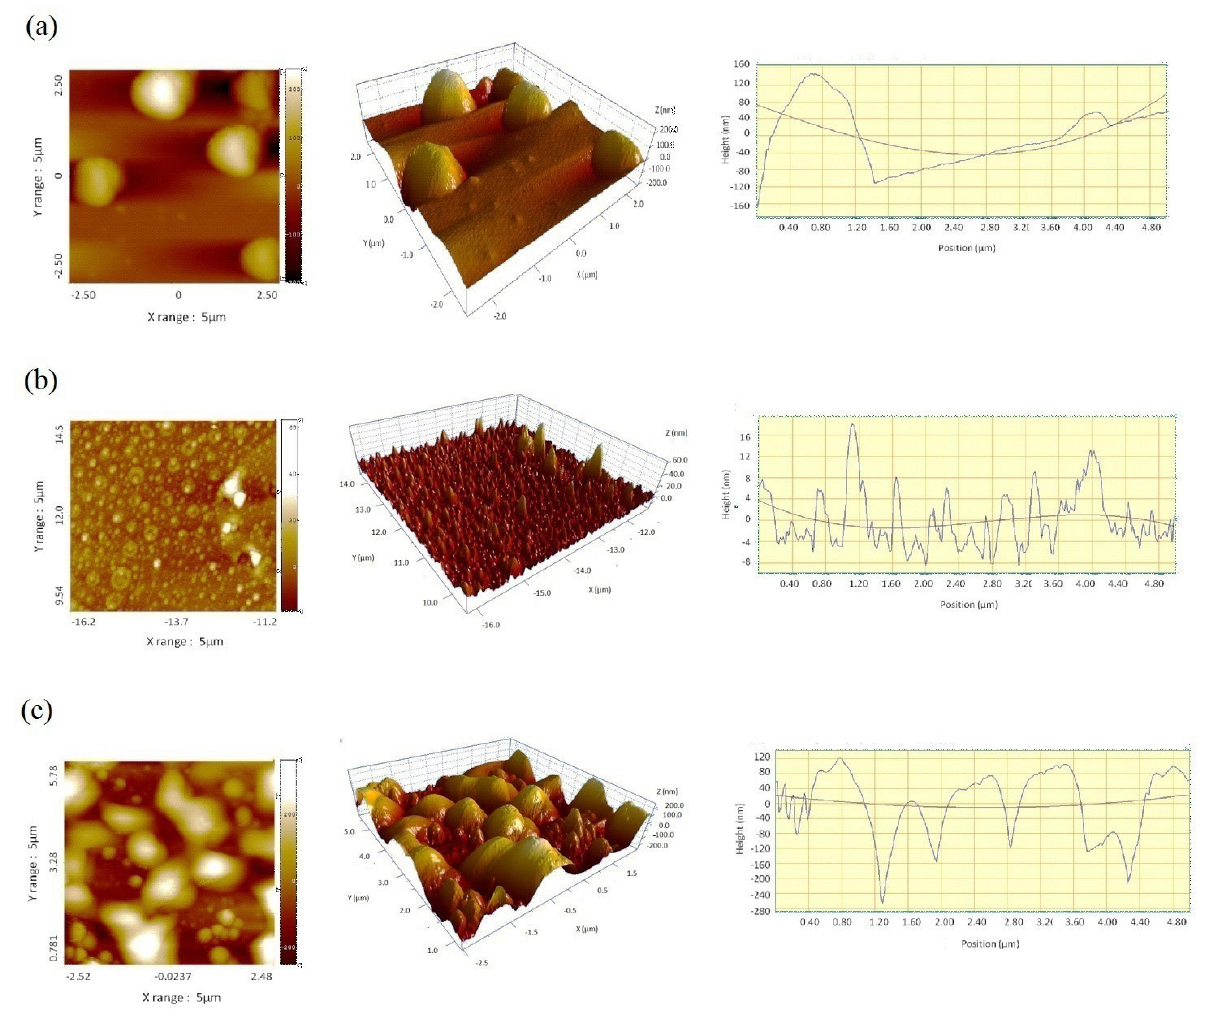
Figure 3: The AFM images of (a) SSM, (b) TTM, and (c) STM